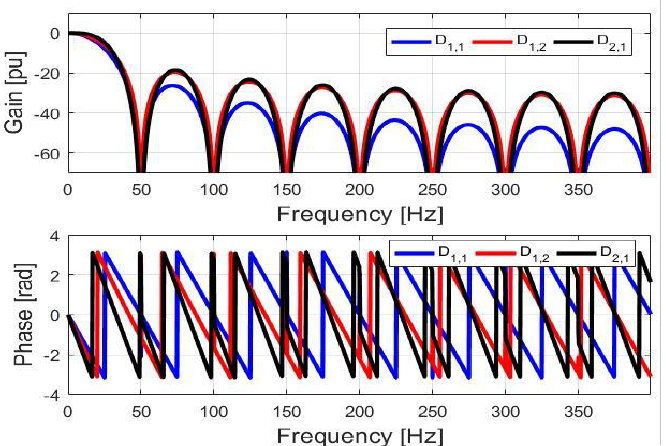
Figure 3. Frequency responses of the zeroth differentiators (transfer functions T m ,0 ( z ) ) obtained by K = 1 for D 1,1 = 16 and D 1,2 = 20, and K = 2 for D 2,1 = 24 estimators related to the DC component ( 𝑚 = 0 ) for f 1 = 50 Hz and f S = 800 Hz ( 𝑁 = 16 ): ( a ) amplitude, and ( b ) phase.